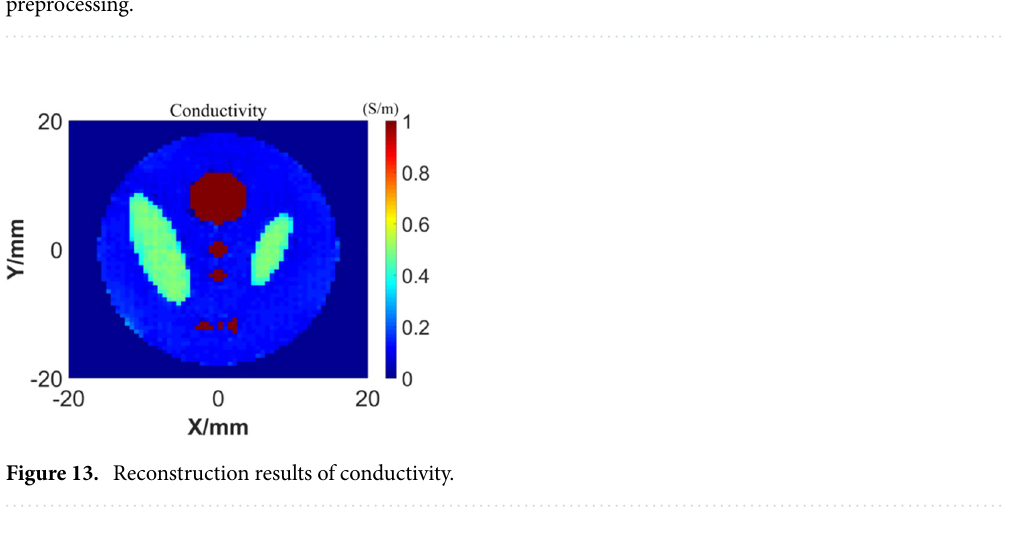
Figure 12. Reconstruction results of acoustic source ( a ) direct reconstruction ( b ) reconstruction after preprocessing.